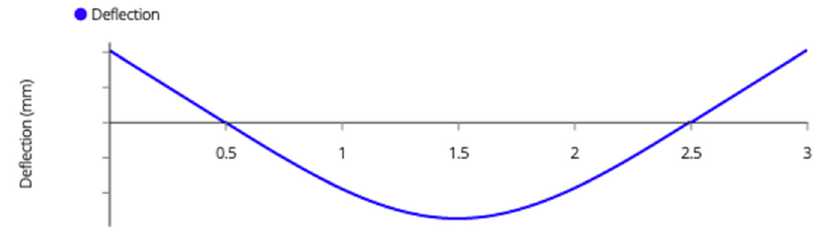
Figure A16. Bottom beam deflection diagram.